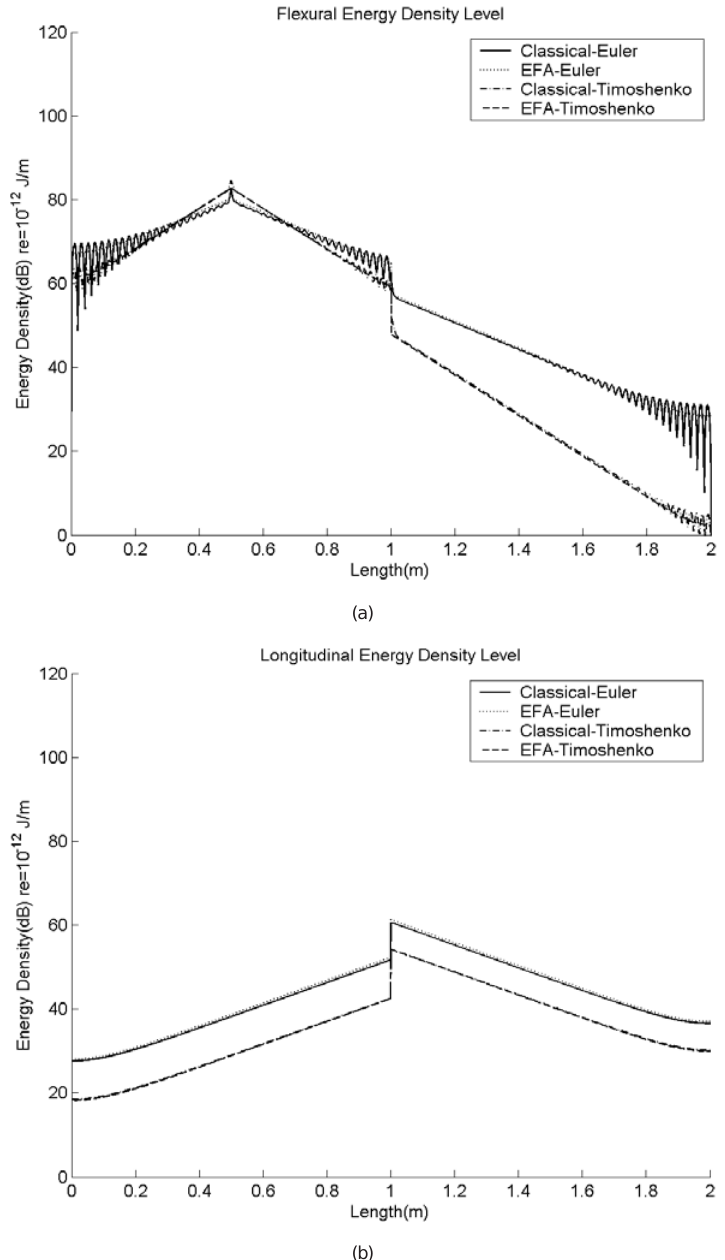
Fig. 15. The comparison of the time- and locally space-averaged energy and power levels of two Timoshenko beam with two Euler-Bernoulli beam structures coupled with θ = 90 ◦ when f = 50 kHz, η = 0 . 1 . The reference energy density is 1 × 10 − 12 J / m and the reference power is 1 × 10 − 12 W; (a) Flexural energy, (b) Longitudinal energy, (c) Flexural power, (d) Longitudinal power.